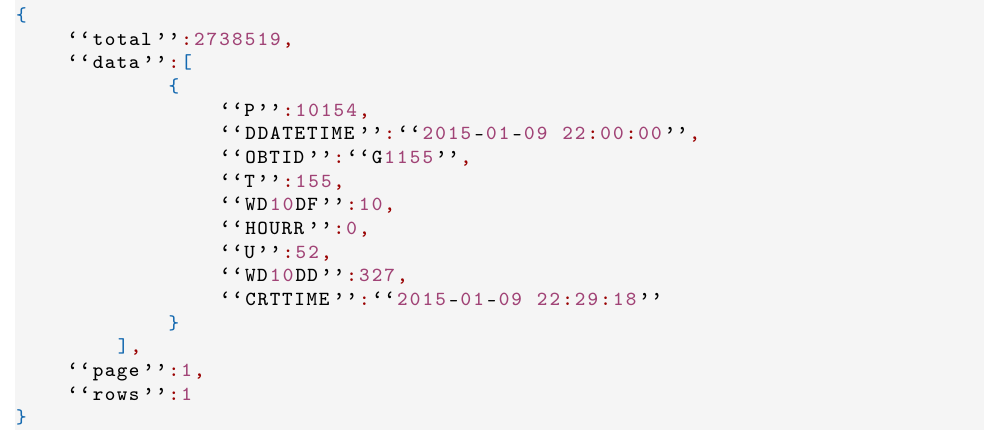
Figure 1. Requesting one record of a regional meteorological observation dataset via the Shenzhen Municipal Government Data Open Platform (https://opendata.sz.gov.cn/data/api/toApiDetails/ 29200_00903515, accessed on 25 July 2021). We request the first record on page 1 via the HTTP GET service with two parameters named page and rows. Ten attributes nested in an attribute named “data” refers to data creation time (termed “DDATETIME”), observation station number (termed “OBTID”), temperature (termed “T”), rainfall (termed “HOURR”), relative humidity (termed “U”), wind speed (termed “WD10DF”), wind direction (termed “WD10DD”), atmospheric pressure (termed “P”), visibility (termed “V”) and record creation time (termed